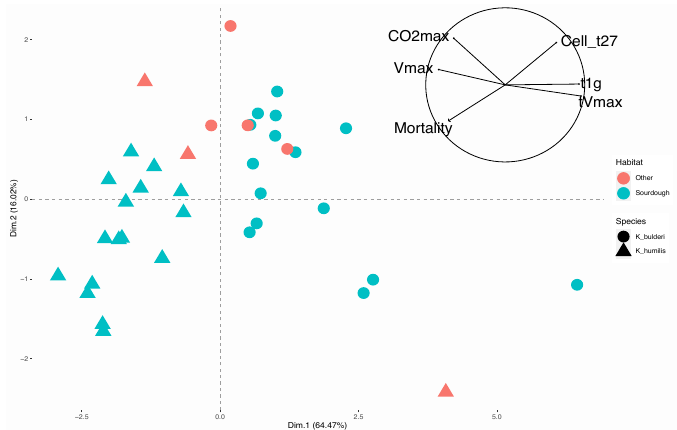
Figure 6: Principal component analysis of 37 K. humilis and K. bulderi strains based on the quantitative variation of maximum CO2 production (CO2max), fermentation latency phase (t1g), maximum CO2 production rate (Vmax), time to reach the maximum production rate (tVmax), log of population size and mortality at the end of the fermentation. The correlations between variables are presented on the right while the figure on the left shows the projection of strains on the first two axes representing 70.64% of the variation. The strains are colored according to their habitat of origin. Sourdough strains are indicated in blue and non-sourdough strains in red. Their species is indicated by symbol. Kazachstania humilis strains are indicated by a circle and Kazachstania bulderi strains by a